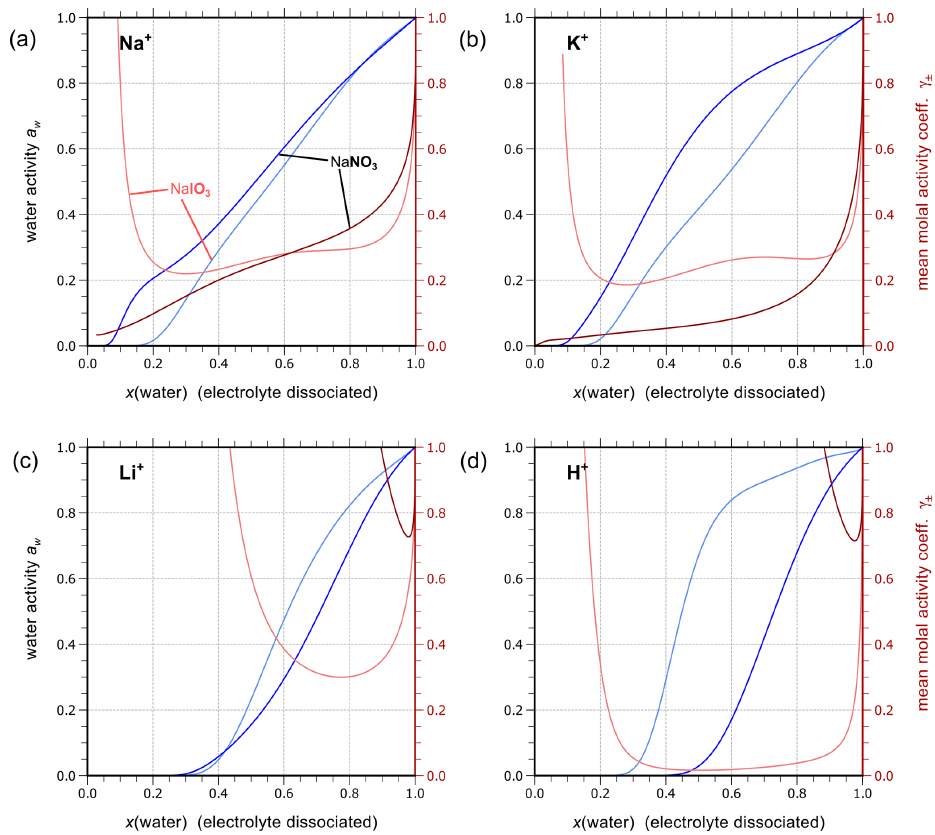
Figure 13. Comparison of AIOMFAC predictions of water activity and mean molal activity coefficients at 298.15K for different binary aqueous solutions of either iodate or nitrate electrolytes with a common cation. Light-colored curves show the iodate case, while darker shades denote the nitrate solutions. (a) NaIO 3 , NaNO 3 ; (b) KIO 3 , KNO 3 ; (c) LiIO 3 , LiNO 3 ; (d) HIO 3 , HNO 3